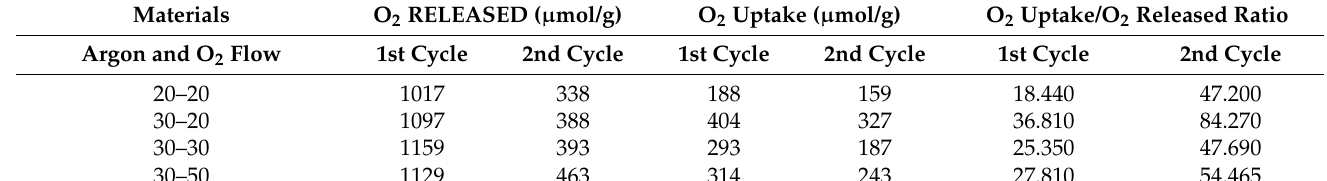
Table 4. Gas flow rate and O 2 storage capacity.